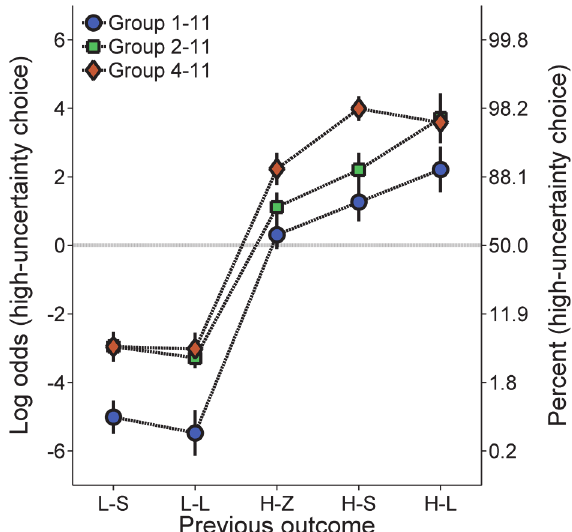
Fig 2. Mean ( ± SEM) log odds of high-uncertainty choices for each group in Experiment 1 as a function of the outcome of the previous choice, collapsed across the probability of high-uncertainty food delivery. A second ordinate showing percentages corresponding to the log odds values was included to aid interpretation. L-S = low-uncertainty-small; L-L = low-uncertainty-large; H-Z = high-uncertainty-zero; H-S = high-uncertainty-small; H-L =